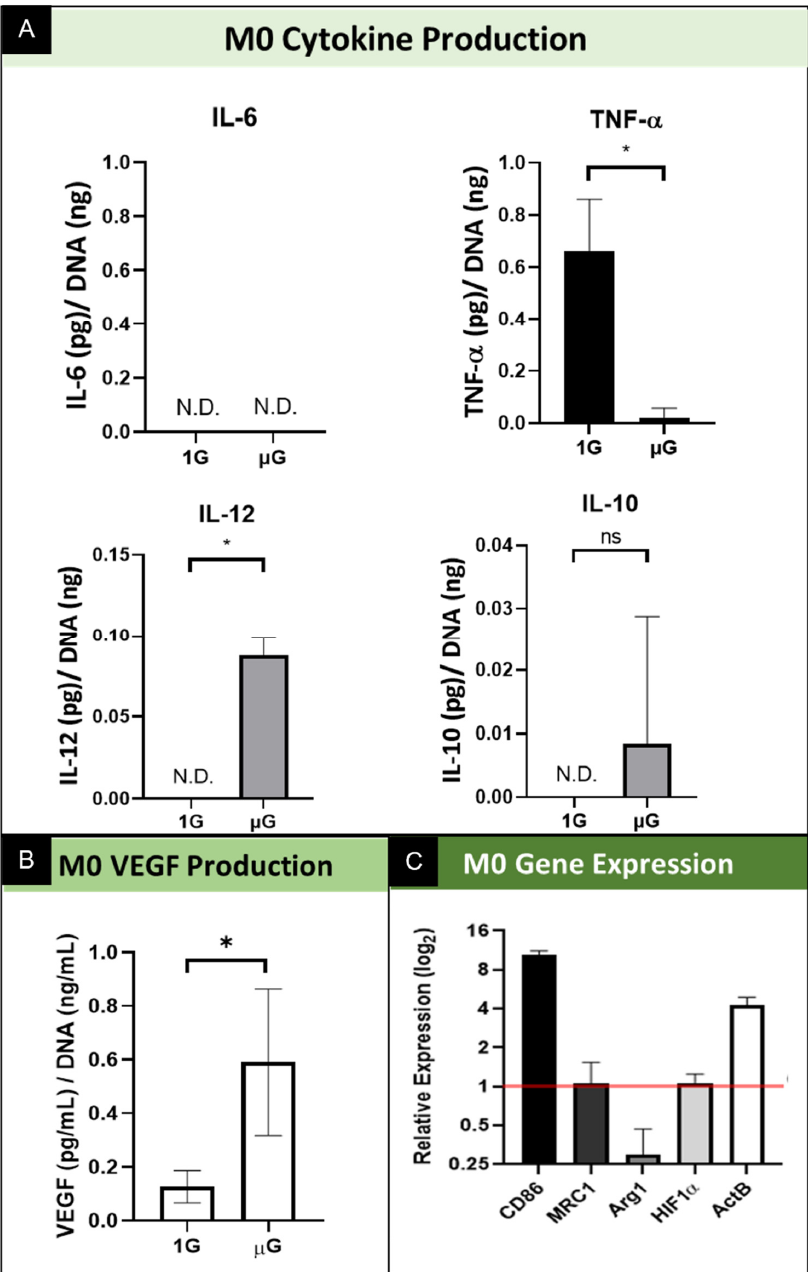
Figure 3. Summary of the effect of simulated microgravity on M0 macrophage protein and gene expression . ( A ) Quantification of M0 macrophage secretion of inflammatory cytokines while cul- tured in both normal gravity (1G) and simulated microgravity (µG) for IL-6, TNF- α , IL-10, and IL- 12. Data normalized to DNA concentration and are presented as Mean +/- SD, n = 3. N.D. indicates the concentration did not reach the threshold for the assay and thus is Not Detected. Significance determined by unpaired Student’s t-test; * denotes p < 0.05; ns denotes non-significant. ( B ) Quanti- fication of VEGF secretion by M0 macrophages cultured in normal gravity (1G) and simulated mi- crogravity (µG). Data normalized to DNA concentration and are presented as Mean +/- SD, n = 3; Significance determined by unpaired Student’s t-test; * denotes p < 0.05. ( C ) Gene expression of M0 phenotype macrophages for M1 specific (CD86) and M2 specific (MRC1 and Arg1) genes, transcrip- tion factor, HIF1 α , and structural gene ActB. Data displayed as relative expression of simulated µG samples compared to 1G controls (red line).